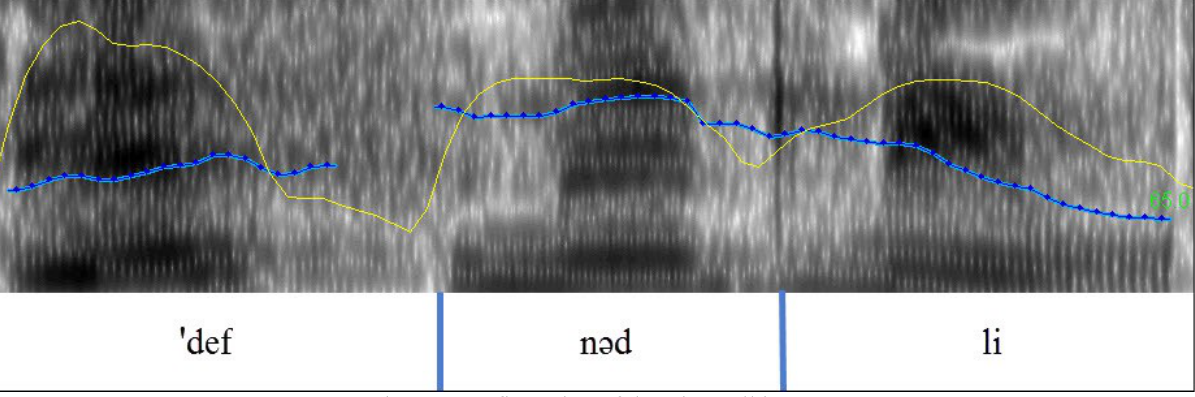
Fig. 3 – Configuration of the Rise-Fall in IE Notes: blue curve signifies F0; yellow curve signifies